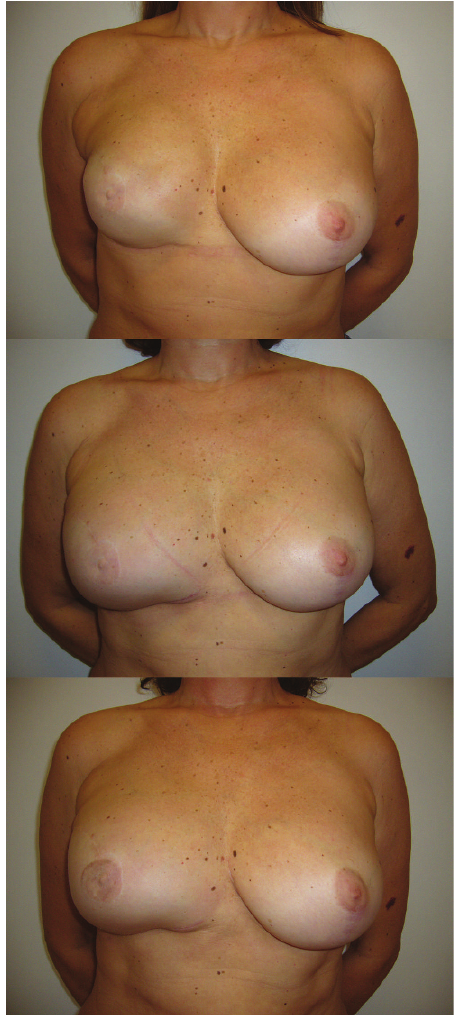
Figure 1 - On the top, patient with fibrosis and superficial irregularities of the right breast surface with silicone implant reconstruction. After transposition of the omentum flap the visible breast growth is registered in pictures below ( 60th, and 100th post-operative day).